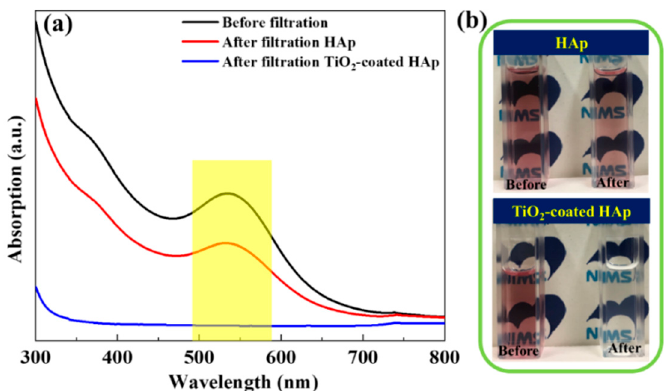
Figure 6. ( a ) UV-vis spectra of the Au colloidal suspensions before and after the filtration by using the membrane fabricated by the HAp and TiO 2 -coated HAp whiskers; ( b ) photographs showing the color difference of these Au colloidal suspensions.